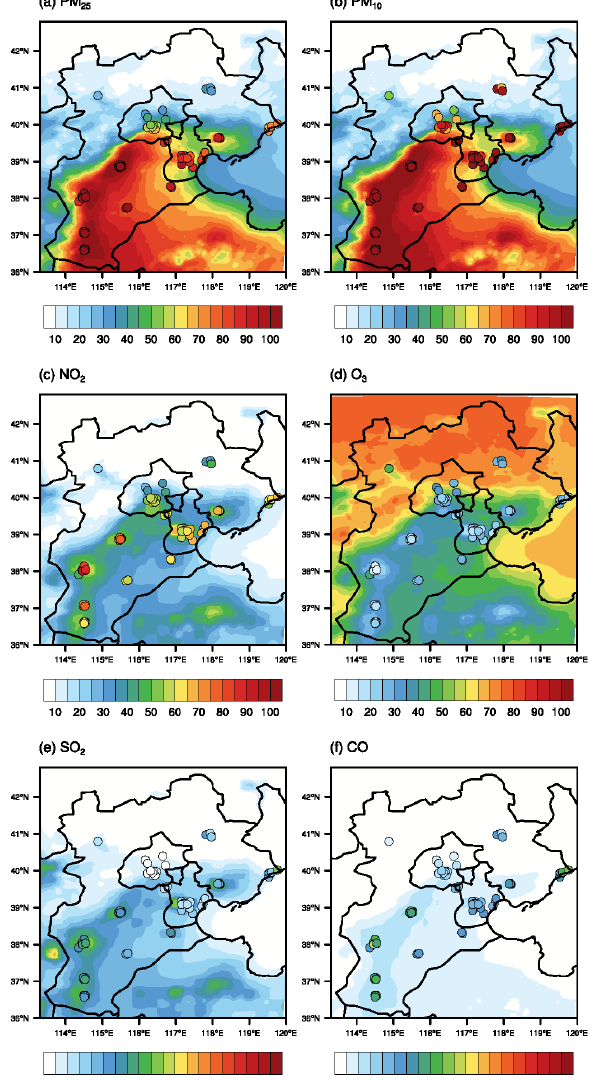
Figure 4. The spatial distribution of simulated (shading) and observed (dots) concentrations for ( a ) PM 2.5 , ( b ) PM 10 , ( c ) NO 2 ( d ) O 3 ( e ) SO 2 and ( f ) CO averaged in January 2016 (in units of μ g/m 3 , except mg/m 3 for CO).